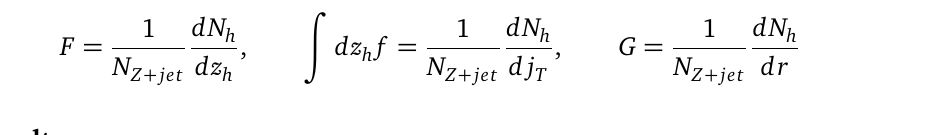
distributions (left) and r distributions (right) at T